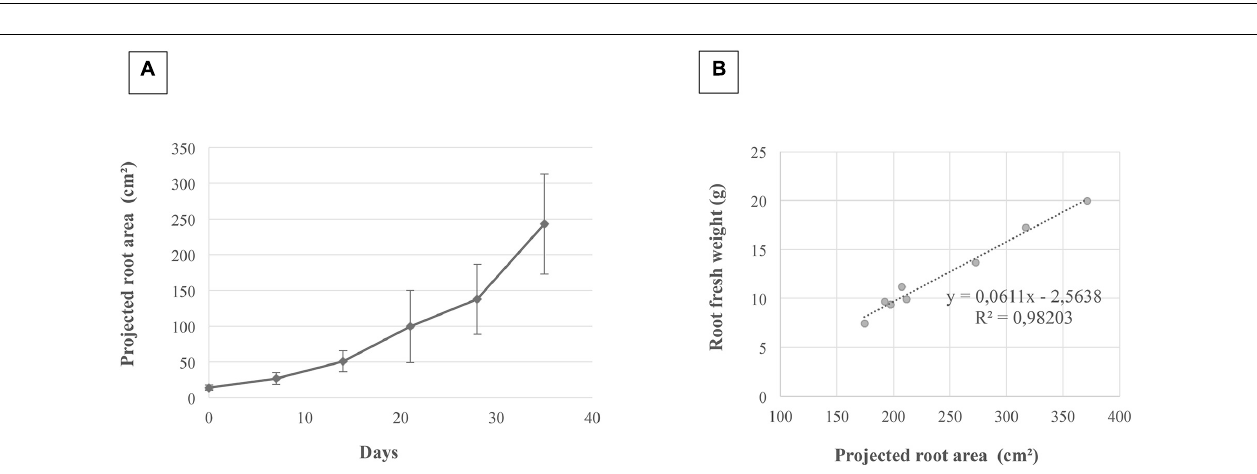
the sand was around 0.8, which highlight the visualization of was 15.2 µ